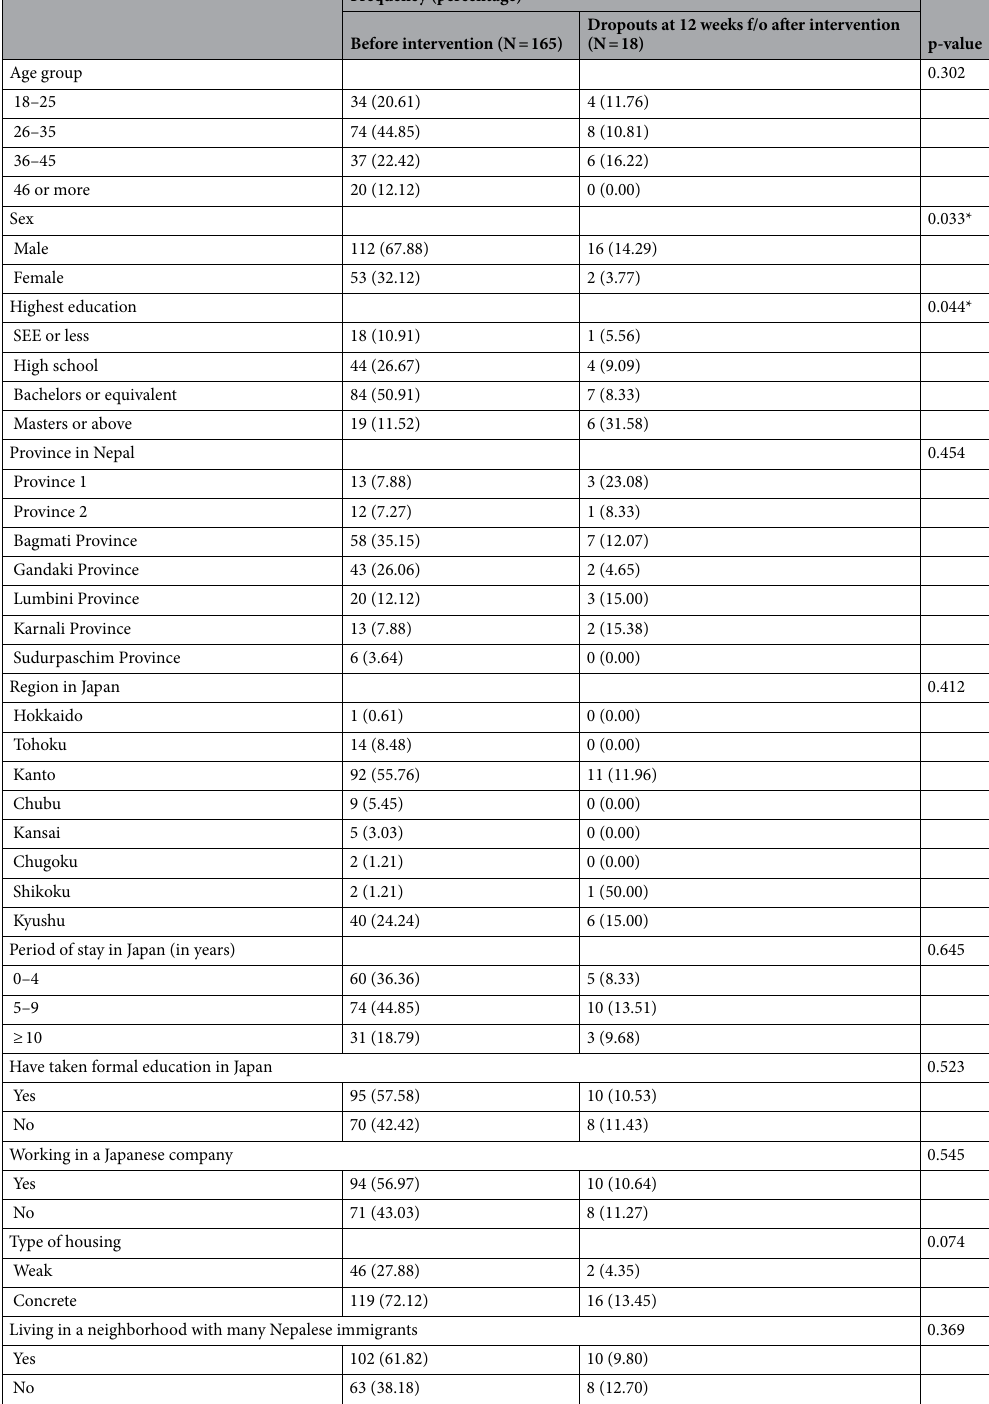
Table 1. Sociodemographic distribution of study participants at baseline and dropout rates at the 12 weeks follow up period. p-value: level of significance among those who dropped out of the intervention at 12 weeks follow up period and those who didn’t obtained by Fisher’s exact test, *p-value < 0.05, N: Total sample size, f/o: follow up, SD: Standard Deviation, SEE: Secondary Education Examination (refers to the examination of 10th grade of schooling in Nepal), dropout rate = number of dropouts at 12-weeks post-intervention follow-up/total number of respondents at pre-intervention ×